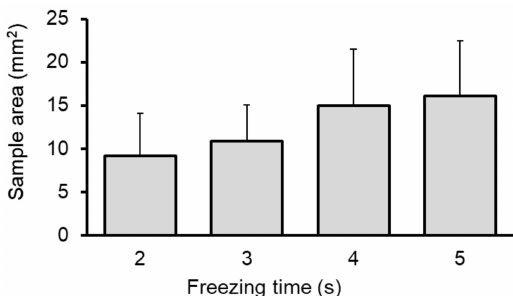
Figure 3. Surface area of peripheral lung lesion samples obtained via cryobiopsy according to the freezing time during cryobiopsy. The graph shows that a larger surface area can be obtained with an increased freezing time ( p = 0.007).